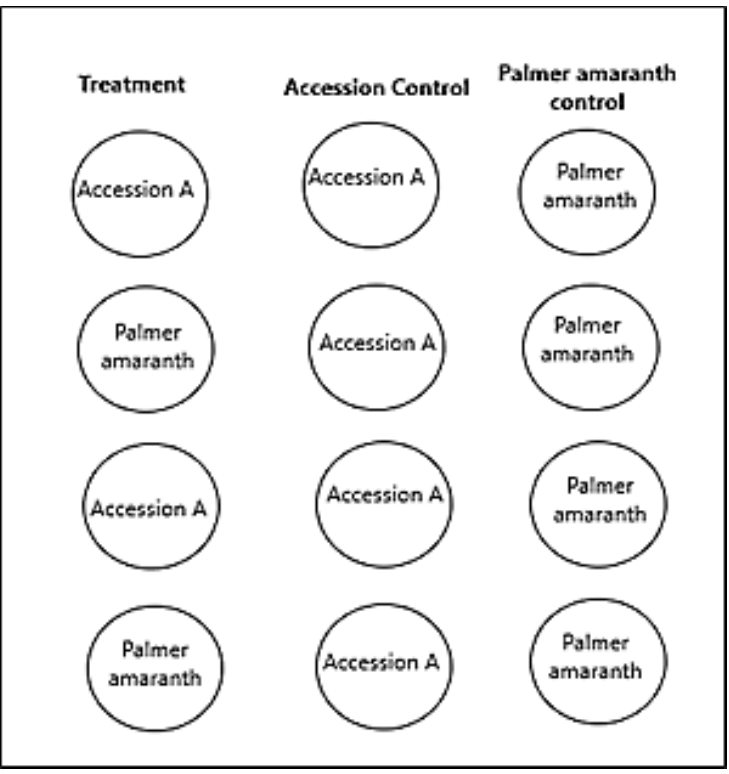
Figure 4. Diagrammatic representation of the stair-step setup. There are two columns for every CS line tested: the treatment column and the control column. The treatment column comprises four pots, two containing the same CS lines and two containing Palmer amaranth (PA). The treatment column starts with a pot of CS cotton, followed by a pot of PA, a pot of the same CS line, and a pot of PA. The control column is composed of four descending pots of the same CS line. This design was repeated for every CS line tested.